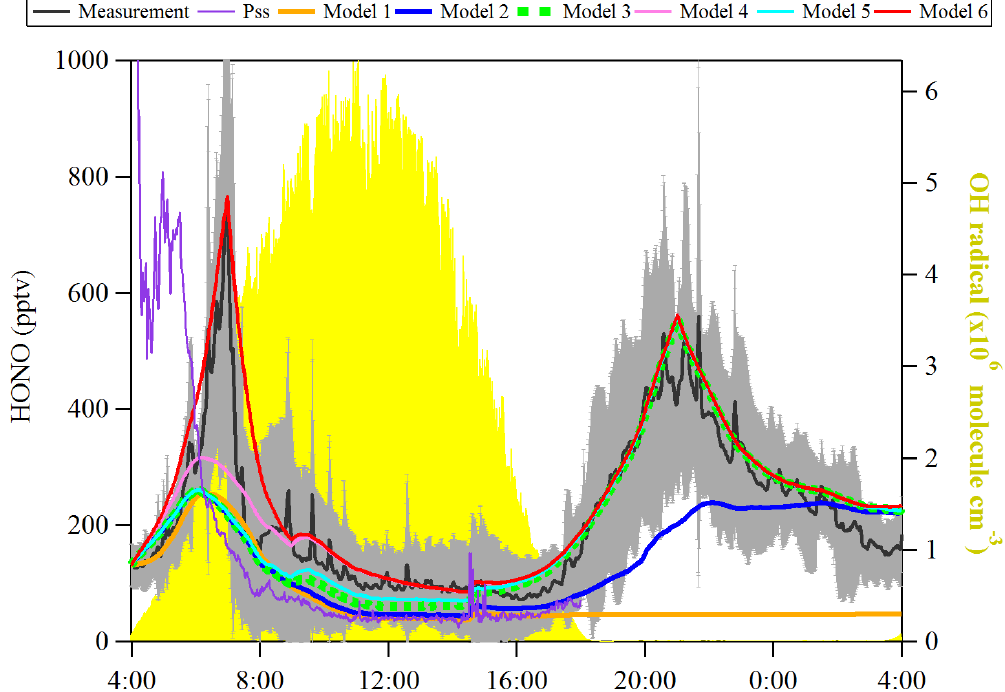
Figure 6. Observed average HONO atmospheric concentration (black line, ± 1 σ in shaded area) and the model calculated HONO con- centration including different HONO production and loss processes. The particle size spectrometer presents model results by assuming an instantaneous photo-equilibrium between the gas-phase formation (Reaction R7) and gas-phase loss processes (Reactions R1 and R11) of HONO. Model 1 includes Reactions (R1), (R7) and (R11). Model 2 includes Reactions (R1), (R2), (R7) and (R11) and surface deposition from 00:00 to 00:00, whereas Model 3 describes Reactions (R1), (R2), (R7) and (R11) and surface deposition from 17:00 to 08:00. Model 3 is used as the base to investigate the effect of Reaction (R9) (Model 4), Reaction (R5) (Model 5) and the combination of Reactions (R5) and (R9) and dew HONO emissions (04:30–07:00) (Model